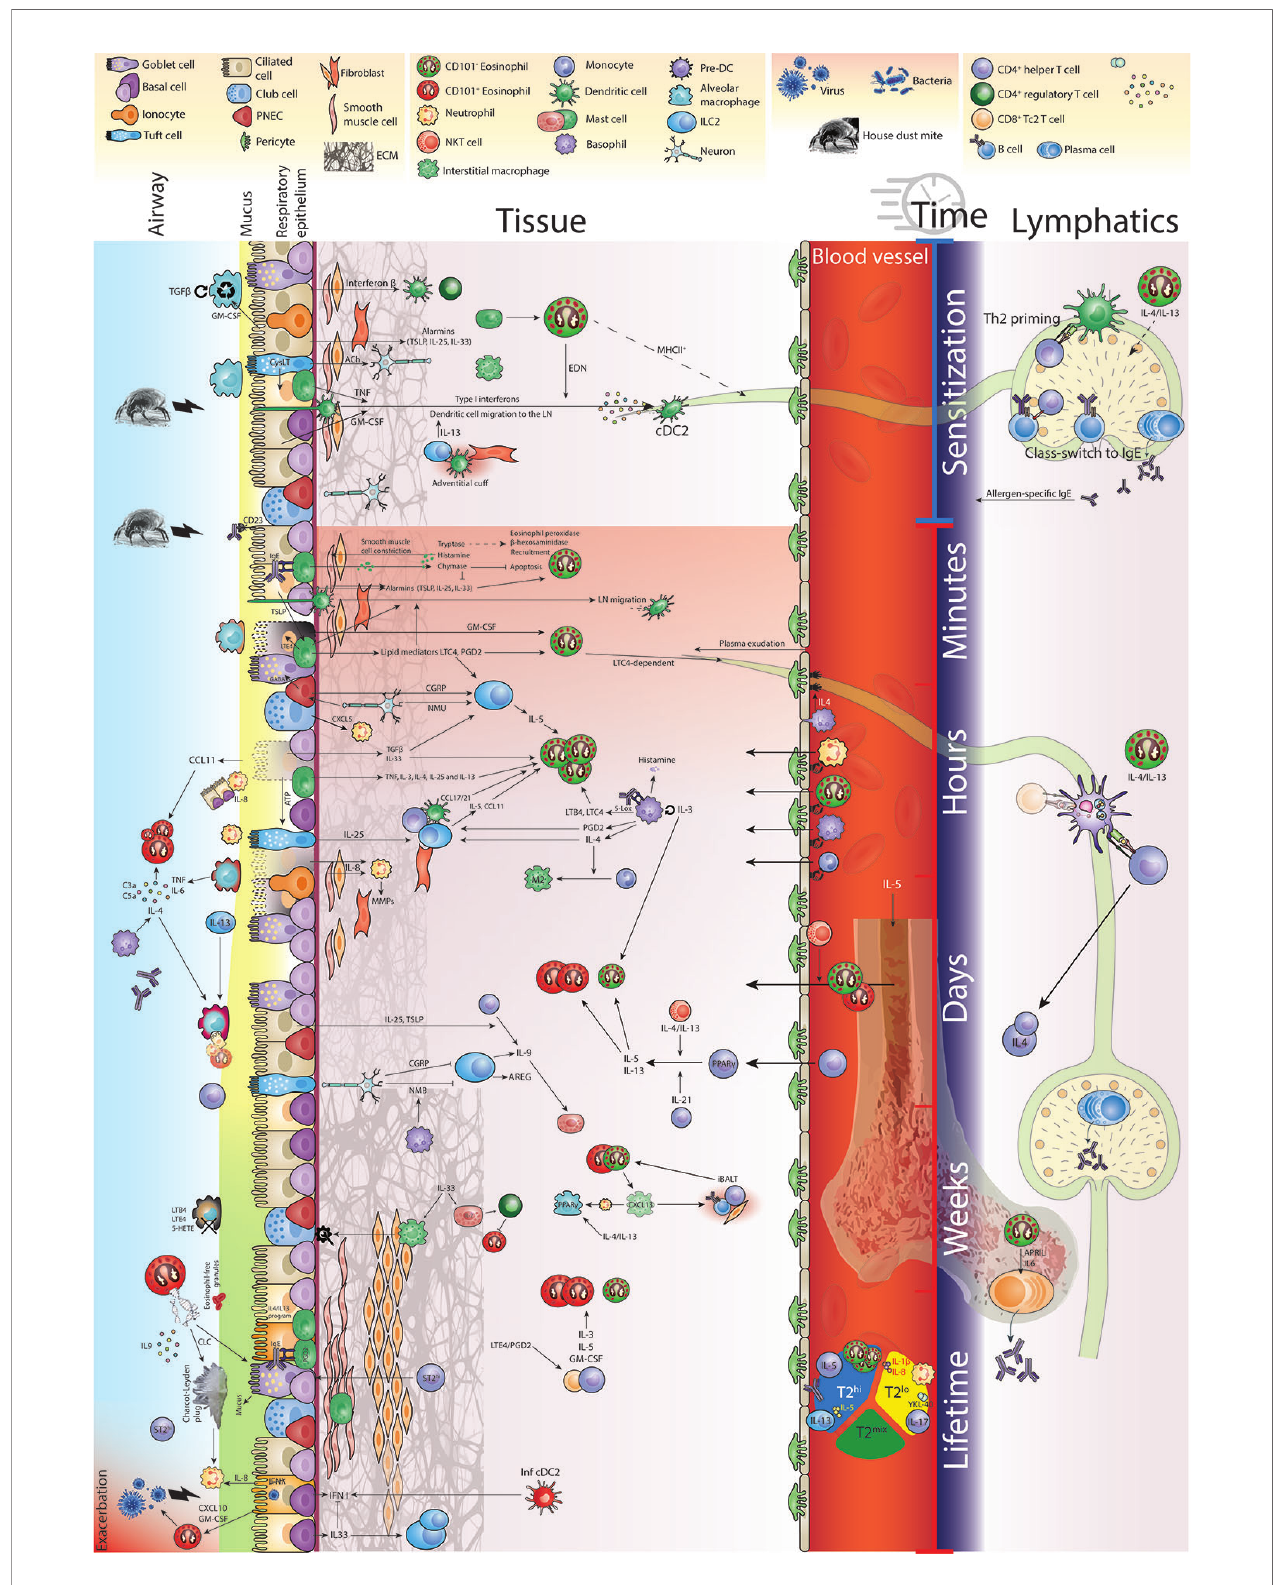
FIGURE 1 | Eosinophil function in time and space during allergic airway in fl